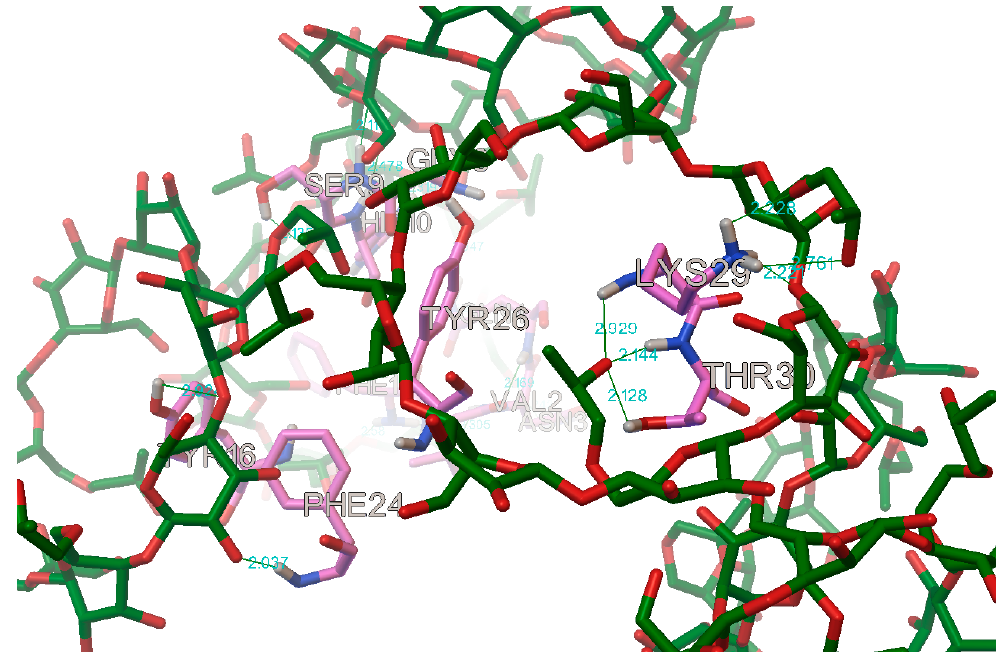
Figure 18. The most commonly occurring hydrogen bonds on the second part of the B chain in the insulin molecule (in this case with the hydroxypropyl- β -cyclodextrin, DS 2). Similar findings have Sadrjavadi K. et al., Alijanvand S.H. et al. and Kaur P. et al., respectively, they found hydrogen bond on B:VAL2, B:GLN4, B:HIS10,